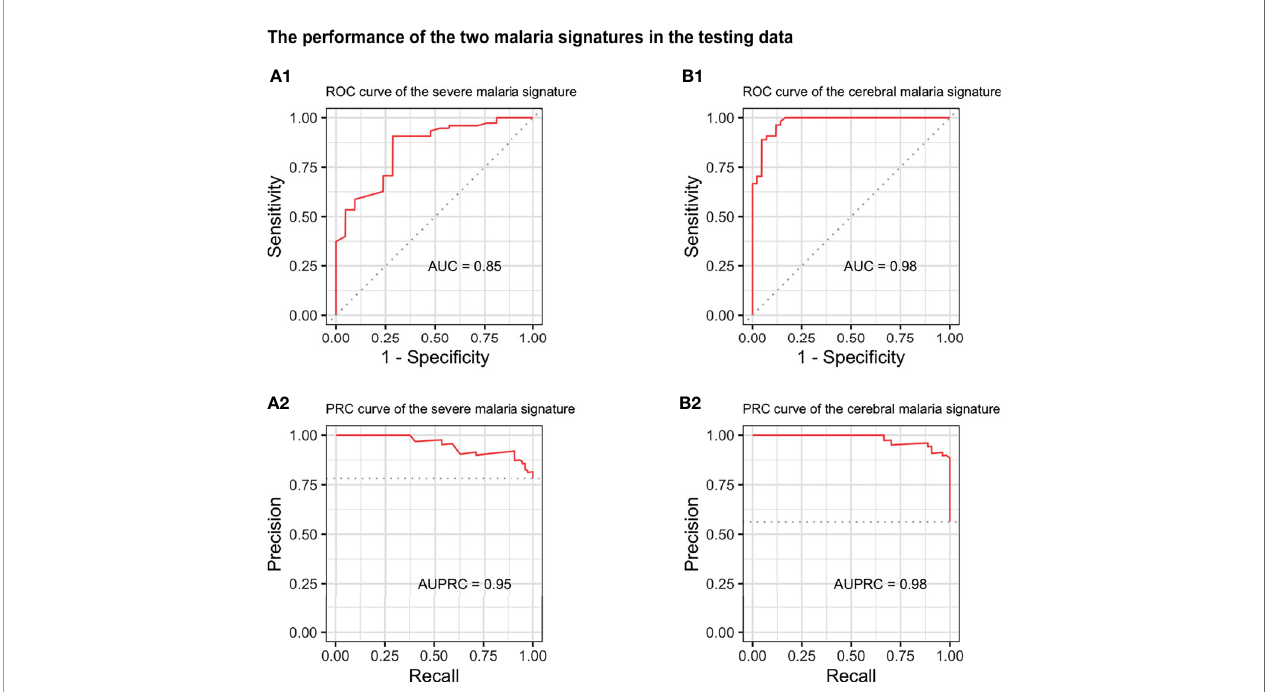
FIGURE 2 | Performance of the severe and cerebral malaria signatures in the independent testing dataset. The performance of the 28-genes severe malaria signature (left) and 32-genes cerebral malaria signature (right) on the independent testing dataset. Upper and lower panels show the receiver operating characteristic (ROC) (A1, B1) and precision-recall (PRC) curves (A2 , B2) , respectively. AUC, area under the ROC curve; AUPRC, area under the PRC